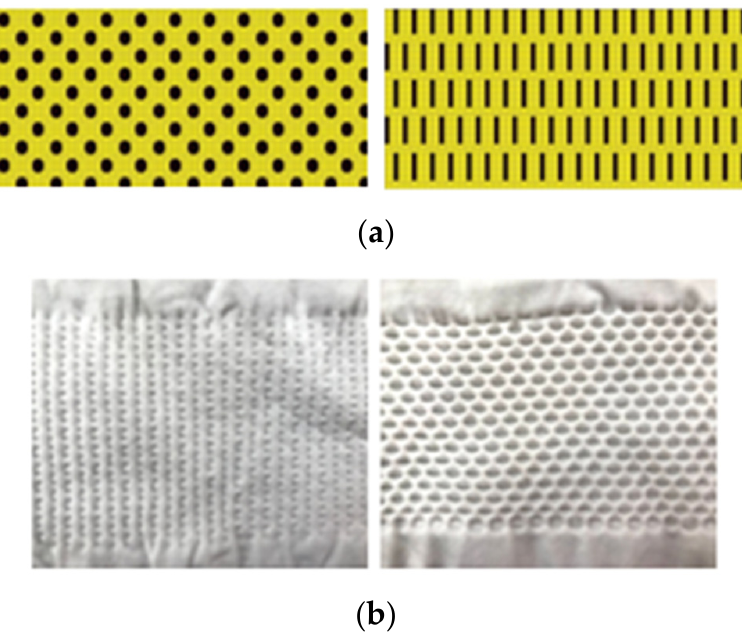
Figure 1. Technical drawing of pattern L and P ( a ) and pattern L and P on seamless knit ( b ). Table 1. Knits studied in the present study.